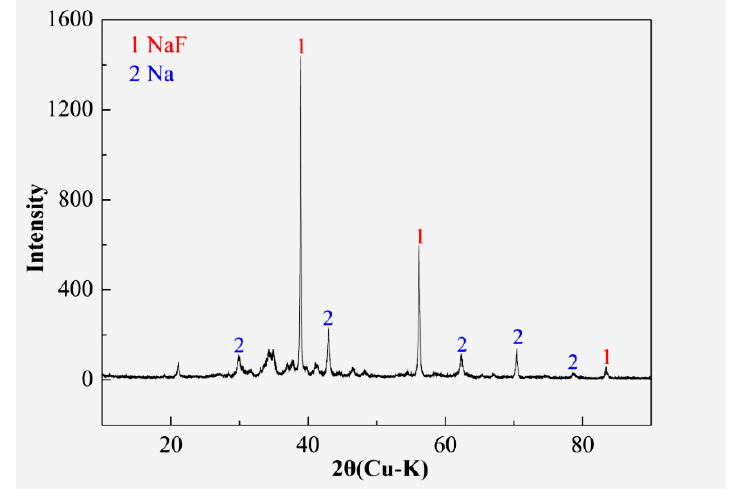
Figure 3. XRD result of the white powder collected from the cover of the furnace.